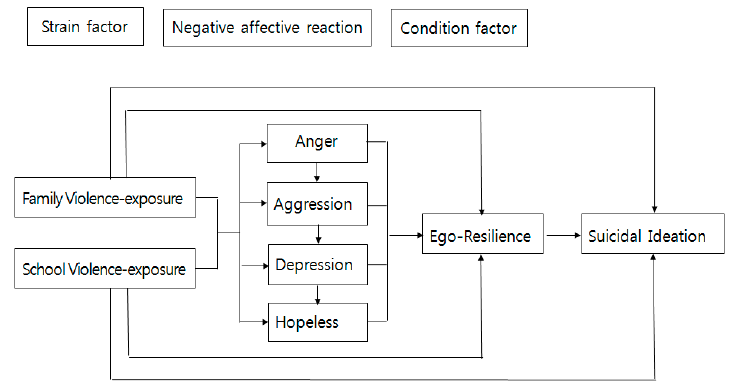
Figure 1. Conceptual framework.